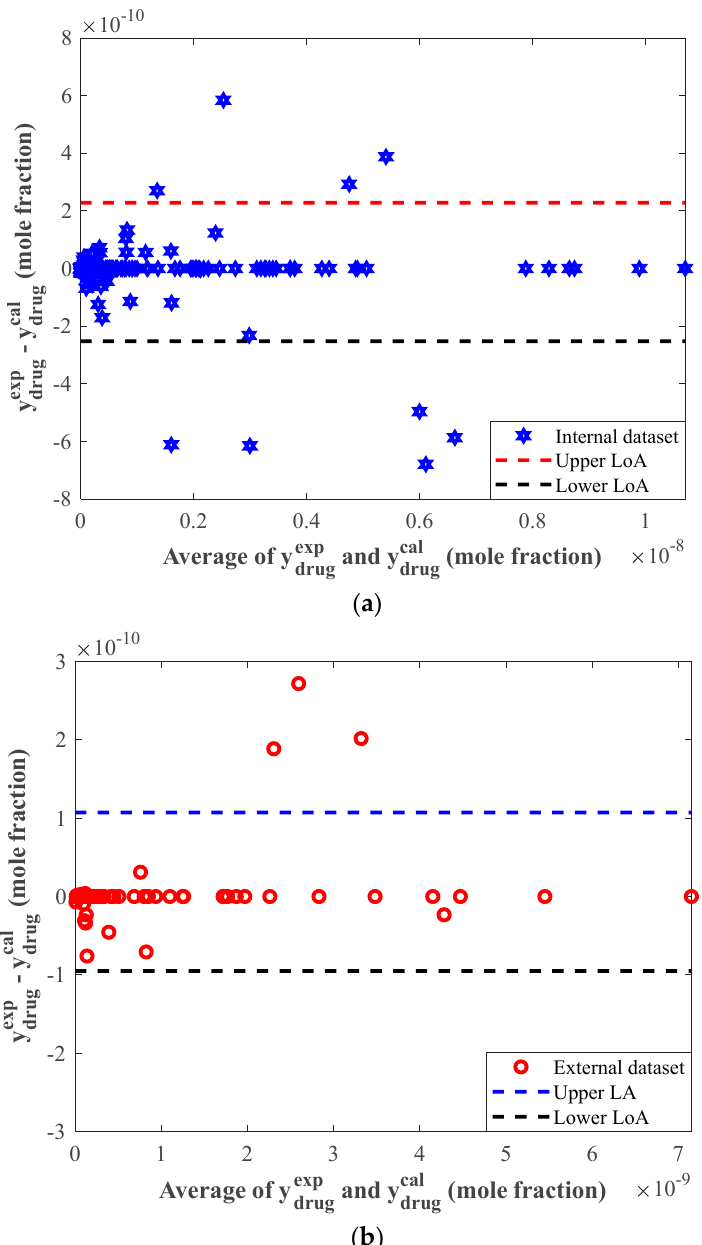
of 63 external data points (4.76%) were located outside the feasible domains.